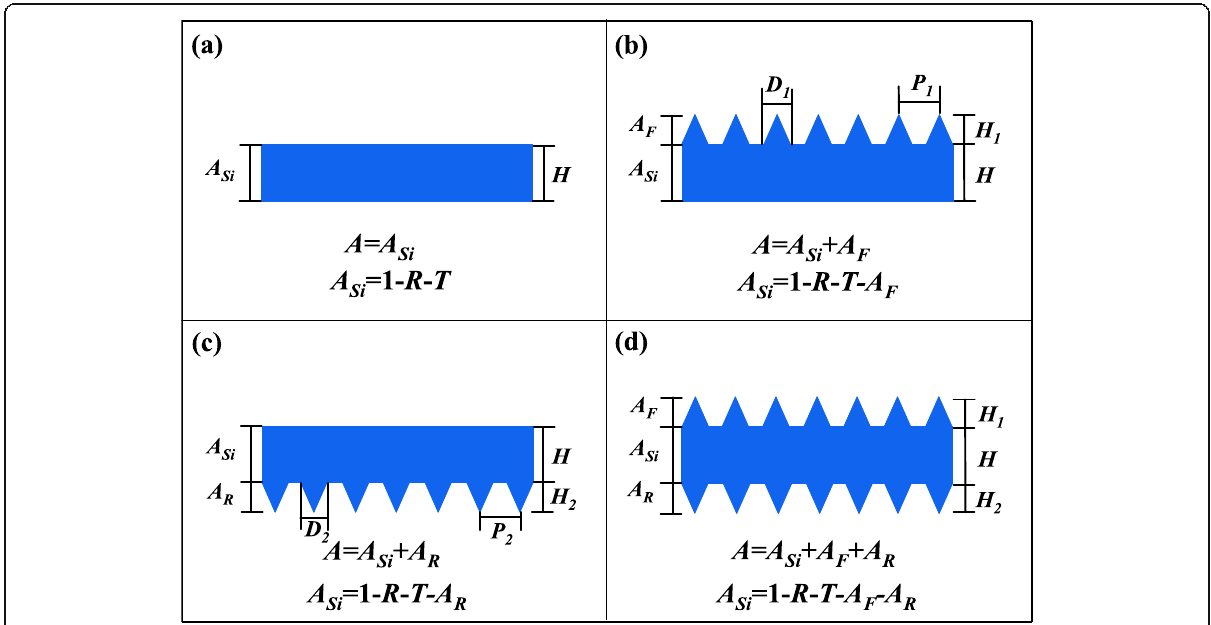
Fig. 1 Different structures of crystalline silicon (CS) thin-film solar cell with or without pyramid gratings. a The bare crystal silicon (BCS). b The front pyramid grating (FPG). c The rear pyramid grating (RPG). d The double-sided pyramid grating (DSPG). ( A F , A Si , and A R represent the light absorption of the front surface gratings, the CS part, and the rear surface gratings, respectively. H is the thickness of the CS layer; P 1 , D 1 , H 1 and P 2 , D 2 , H 2 represent the period, bottom diameter, and height of silicon pyramid of the front or rear surface, respectively)